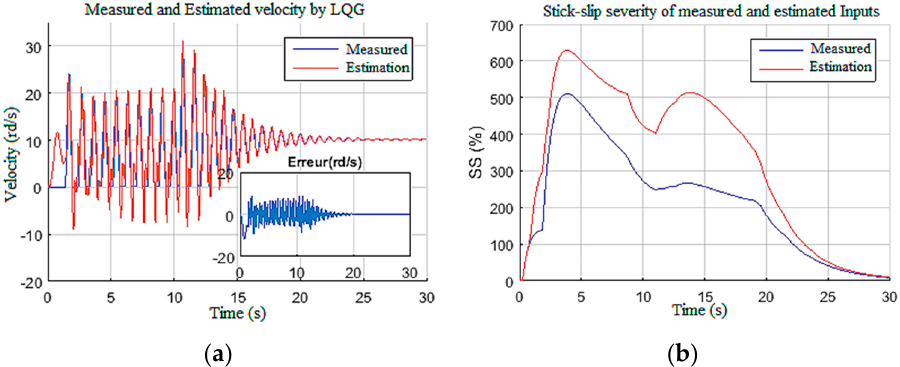
Figure 11. Test outputs for Scenario 1: ( a ) drill bit velocity; ( b ) severity.